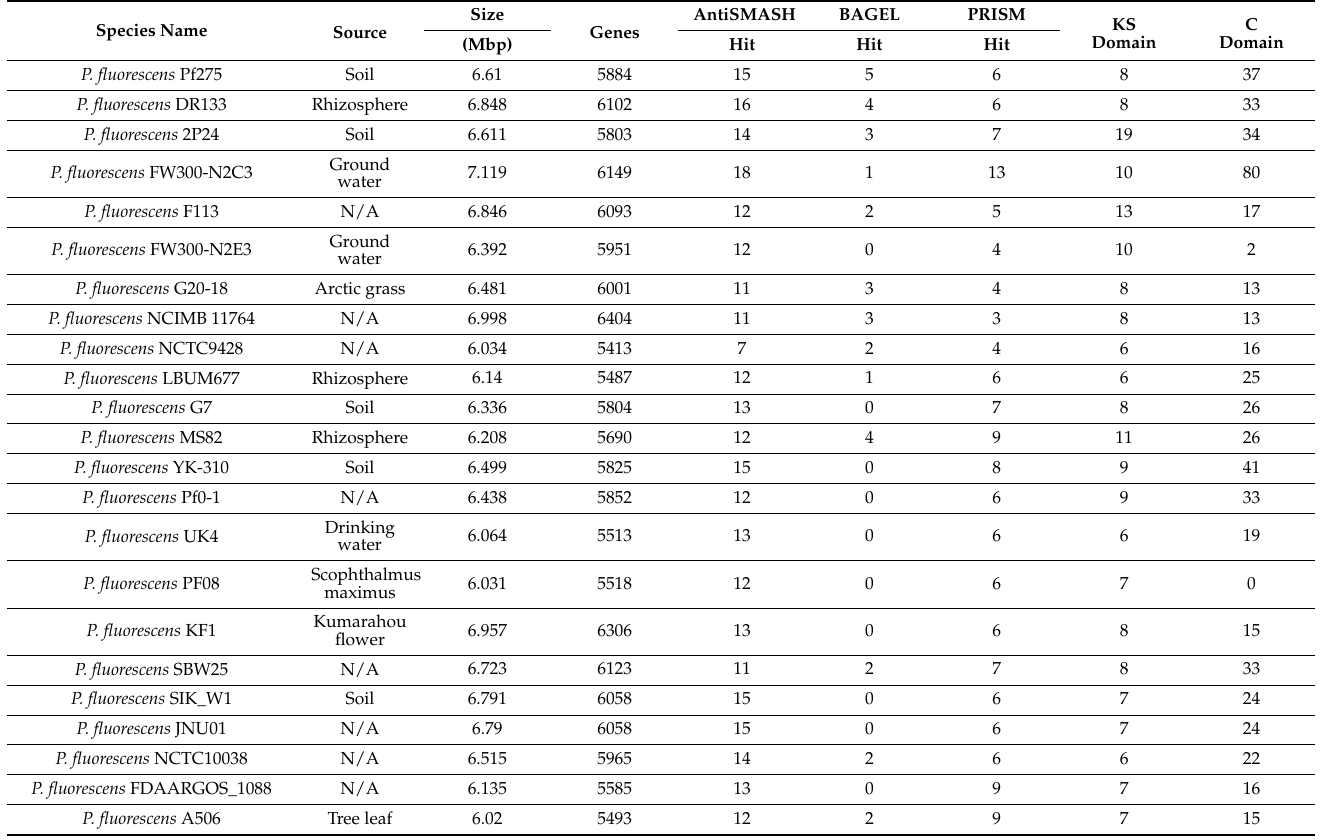
Figure 4. Phylogenetic tree of P. fluorescence sub-species along with the gene number, isolation source, and NP BGCs number determined by antiSMASH. The phylogenetic tree is built using rpoB sequences extracted from the genome based on the maximum likelihood method. Two bar-plots show genome size in thousands of genes on the left, colored by habitats, and the number of BGCs on the right. Species in these two bar-plots keep the same order as the phylogenetic tree. Hybrid clusters are shown separately. The colors matching to habitat types and 20 major NP classes are displayed below the bar-plots. N/A: Not available. a common species, the BGC number shows obvious differences between different strains. Table 2. List of different P. fluorescence reference genomes with different